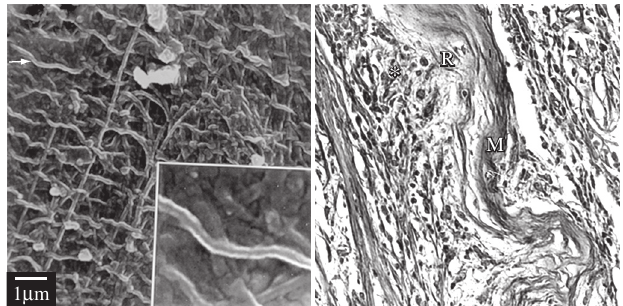
Figure 4. Reconstituted collagen membrane cast from tendon gel at pH 7.4: a) Scanning electron microscopy; and b) Optical microscopy after 20 days from implantation in the dog periodont (Hematoxilin and Eosine staining, 40 x